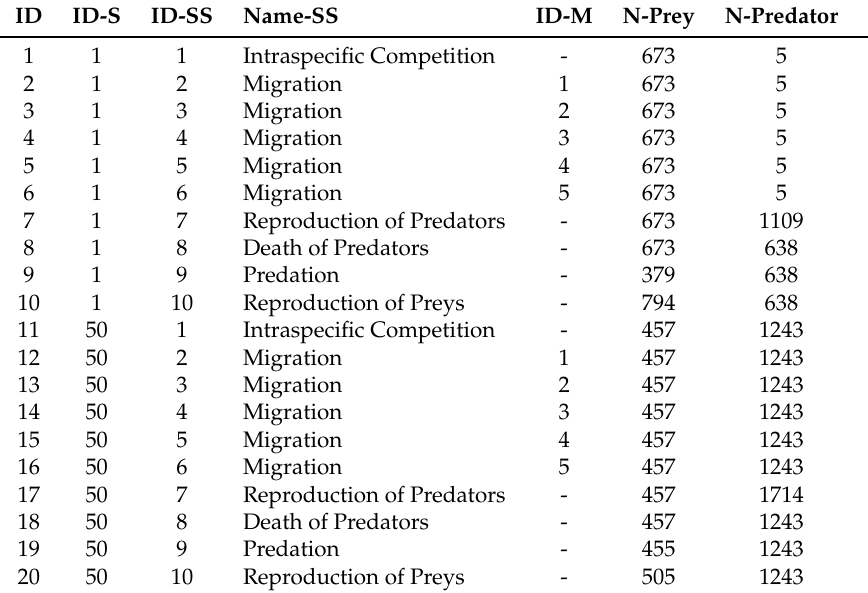
Table 8. Simulation carried out without using agents—Case E.